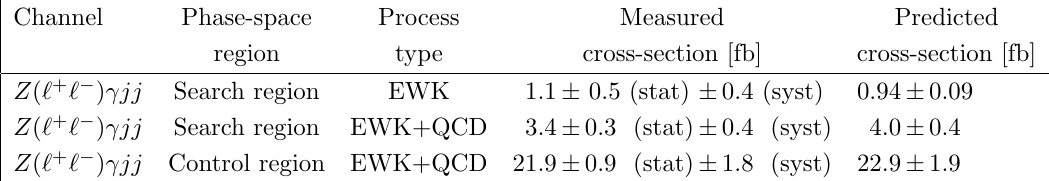
Table 7 . Summary of Z(cid:13)jj production cross-section measurements in the search and control regions for the charged-lepton